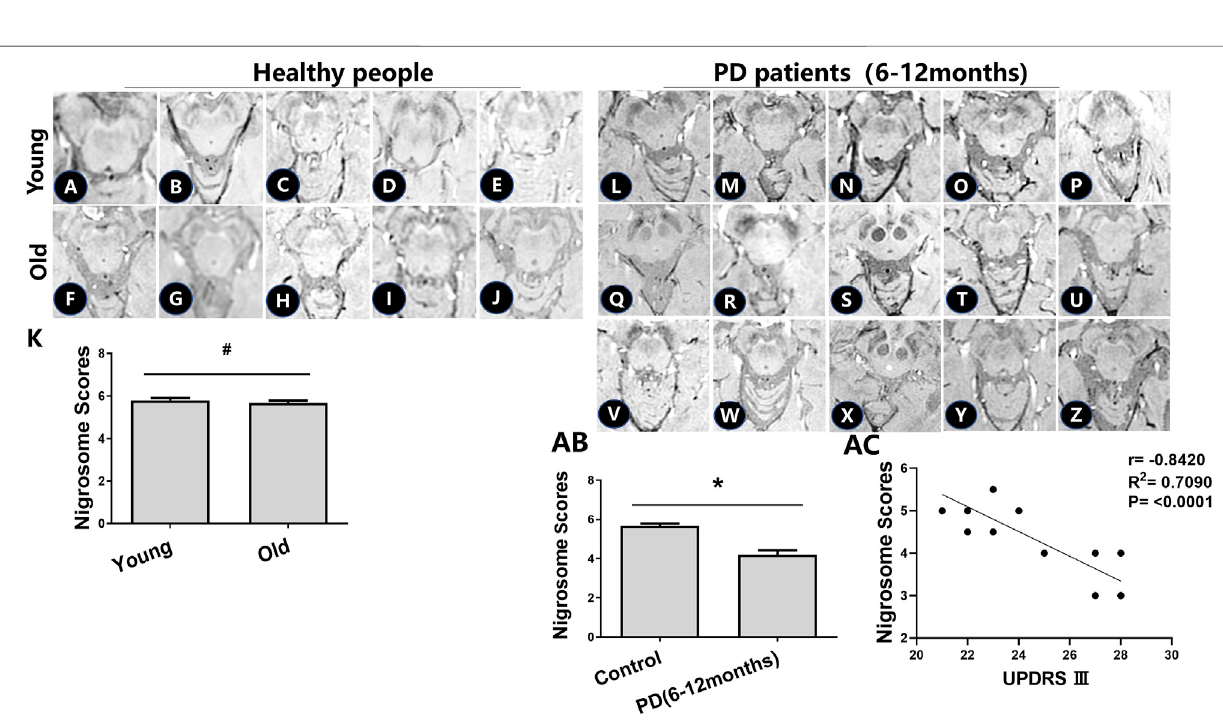
Frontiers in Molecular Biosciences |